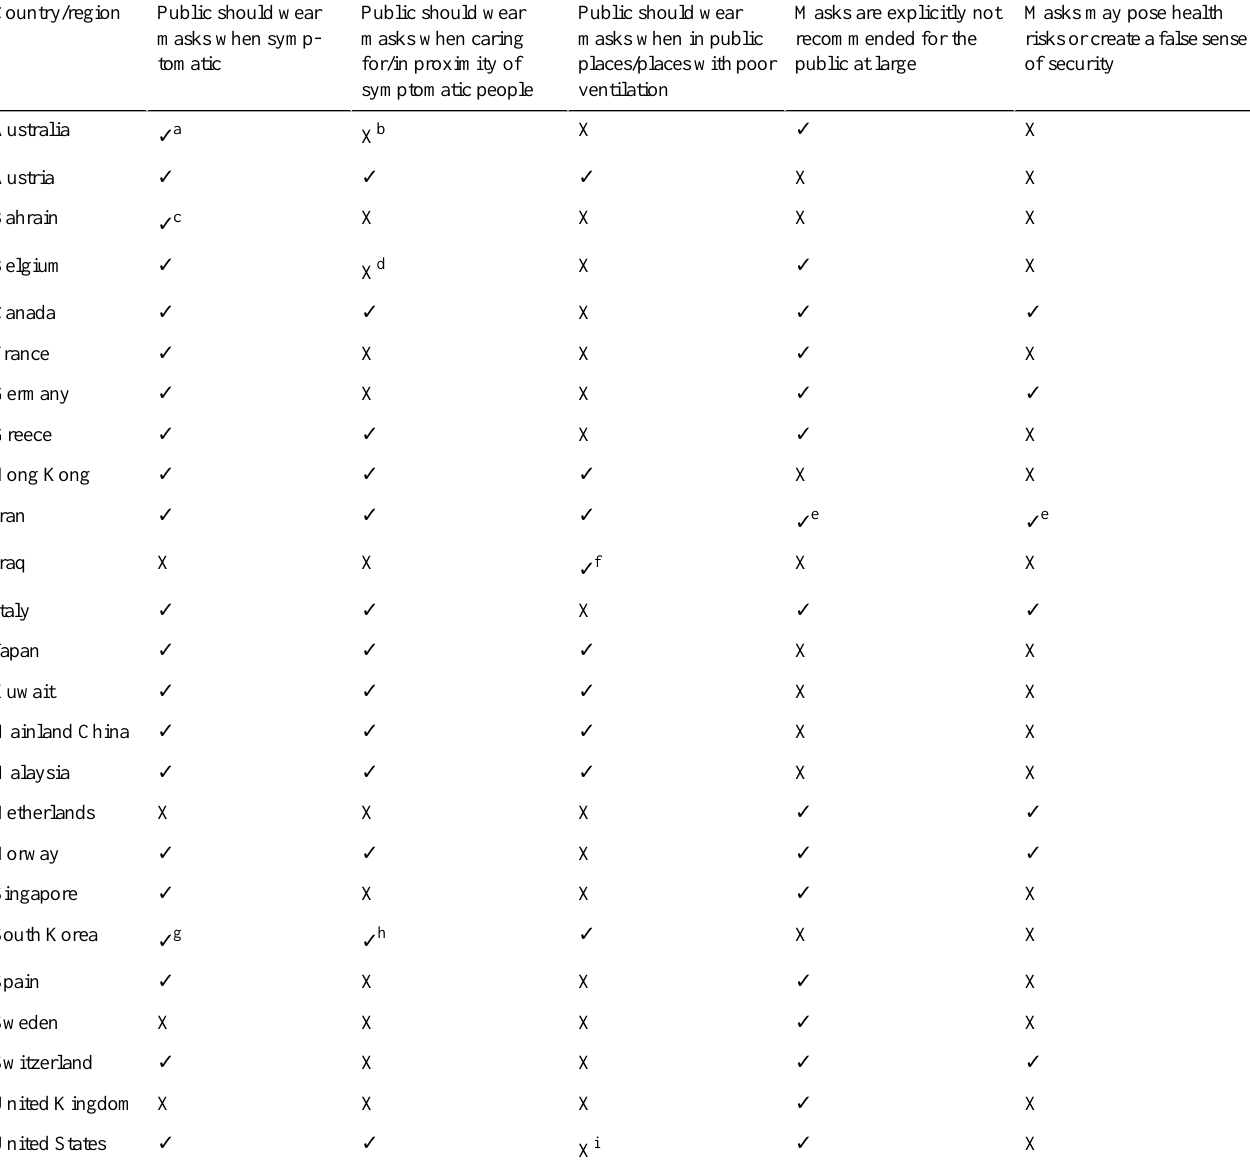
Table 1. Health agency guidance for public use of surgical, medical, and unspecified masks for coronavirus disease as of March 30,